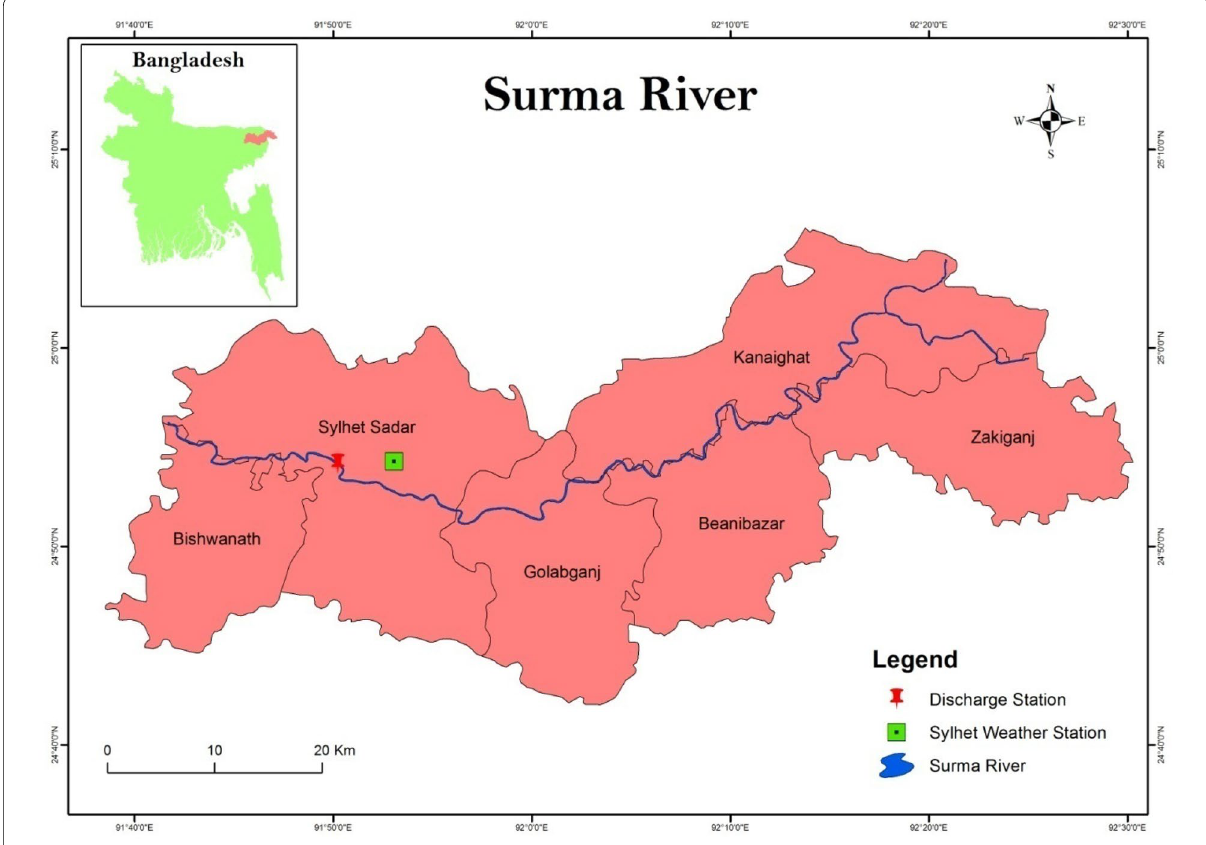
Fig. 1 Location of the Surma River,